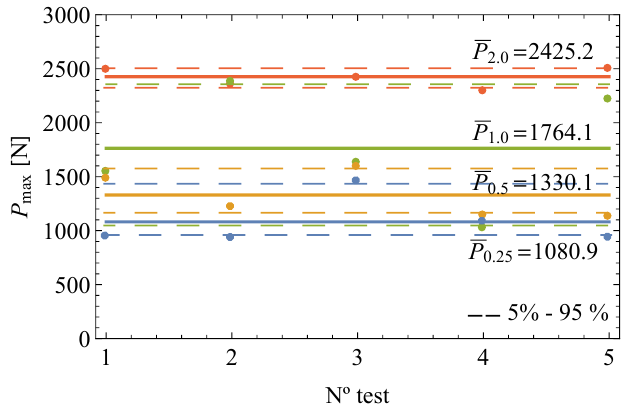
Figure 5. Experimental maximum load values obtained for the different notch radii samples of EPOLAM 2025 with the standard deviations